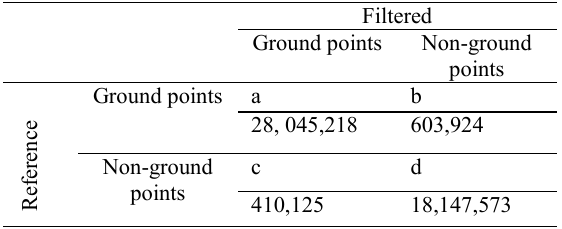
Table 1. Ground filtering performance of proposed algorithm on chosen test site.